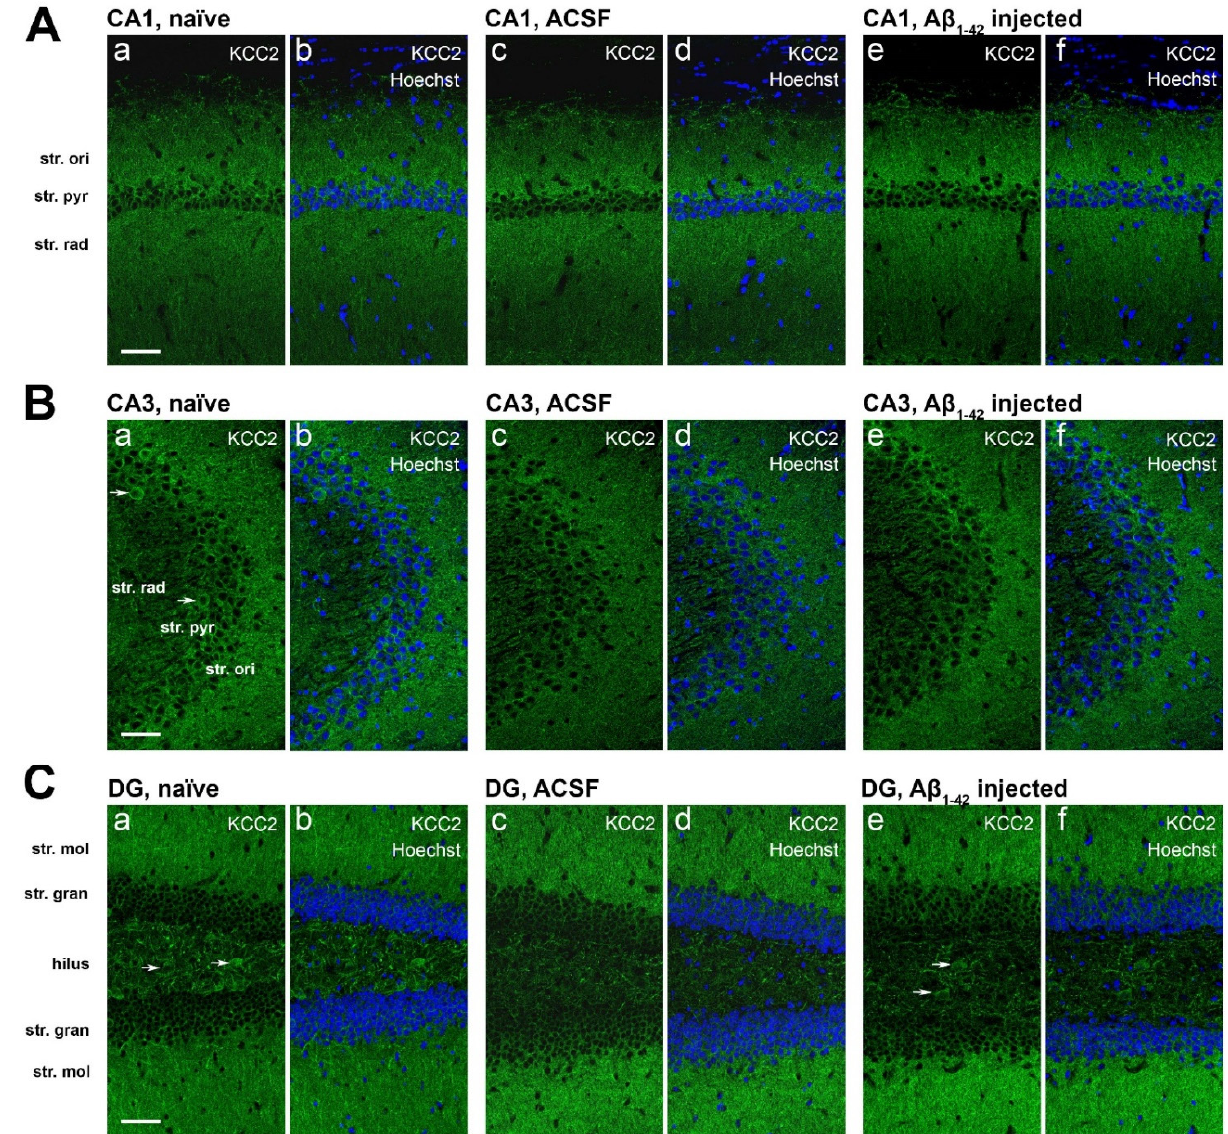
Figure 6. KCC2 expression in the mouse hippocampus. Confocal images of mouse hippocampal sections showing immunofluorescence labeling of KCC2 (green) and Hoechst 33342 (blue) in the mouse hippocampal regions ( A ) CA1, ( B ) CA3, and ( C ) DG of naïve ( a , b ), ACSF ( c , d ), and A β 1-42 - injected mice ( e , f ). Arrows indicate KCC2 is expressed in the soma of neurons in the CA1, CA3, and DG. Scale bar = 50 µ